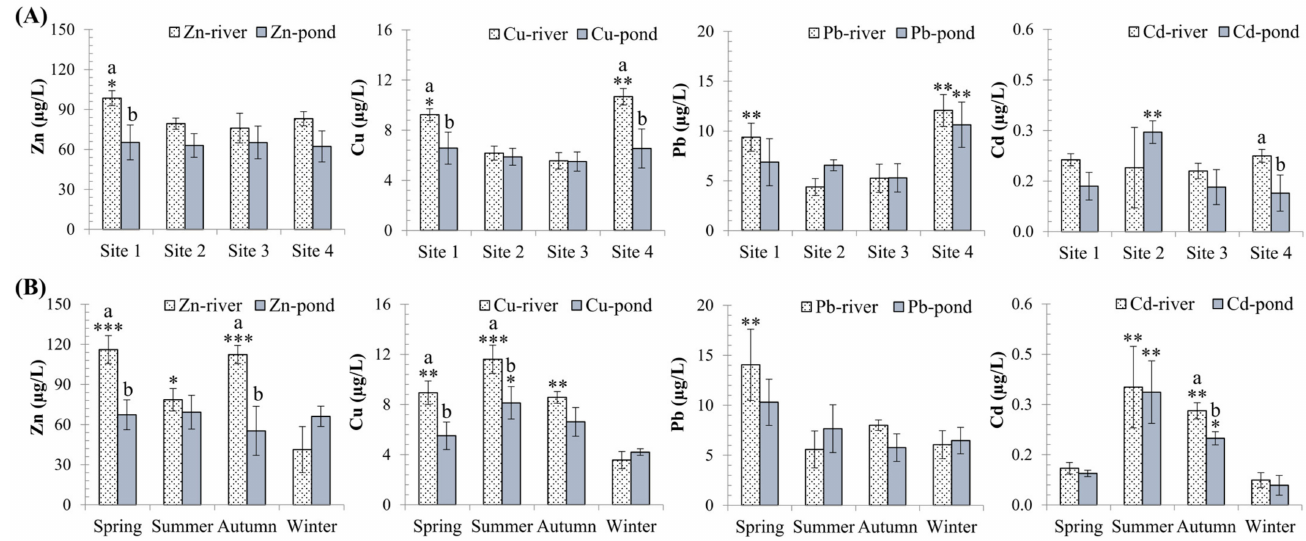
Figure 2. Spatial ( A ) and seasonal variations ( B ) of metals in water ( µ g/L). Significant differences between sampling sites and times in comparison to the lowest value (*) are indicated (mean ± SEM, n = 10–20, * p < 0.05, ** p < 0.01, *** p < 0.001). Different letters (a > b) indicate that values from the ponds and the rivers at the same locations ( A ) or at the same times ( B ) are significantly different ( p < 0.05; ANOVA followed by Tukey–Kramer multiple comparisons